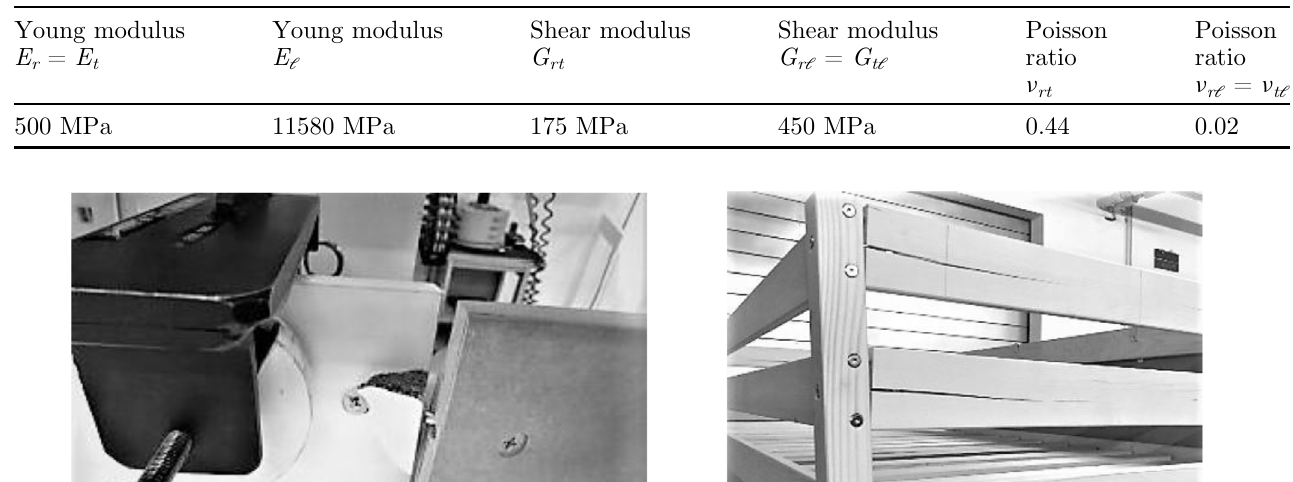
Table 1. Transversely isotropic elastic properties for spruce.